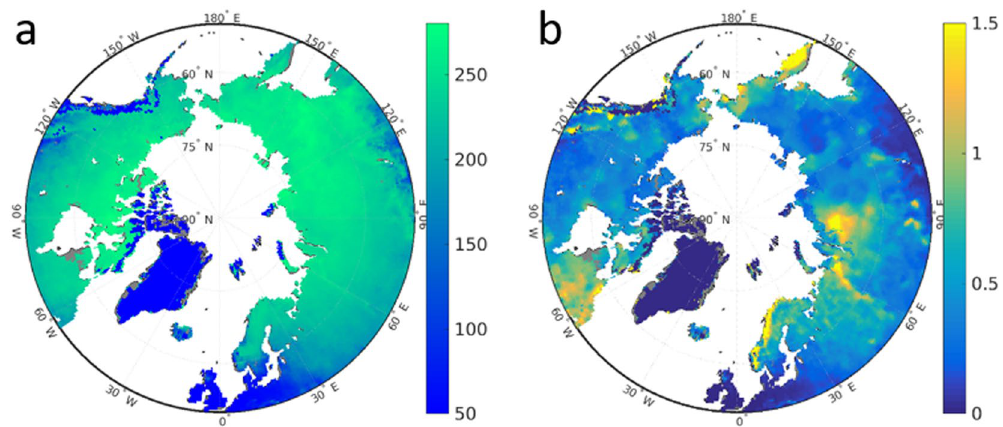
Figure 3. JSBACH CNTL experiment mean snow properties during 1990–2010. ( a ) DJF snow density (kg m − 3 ) and ( b ) annual maximum snow depth